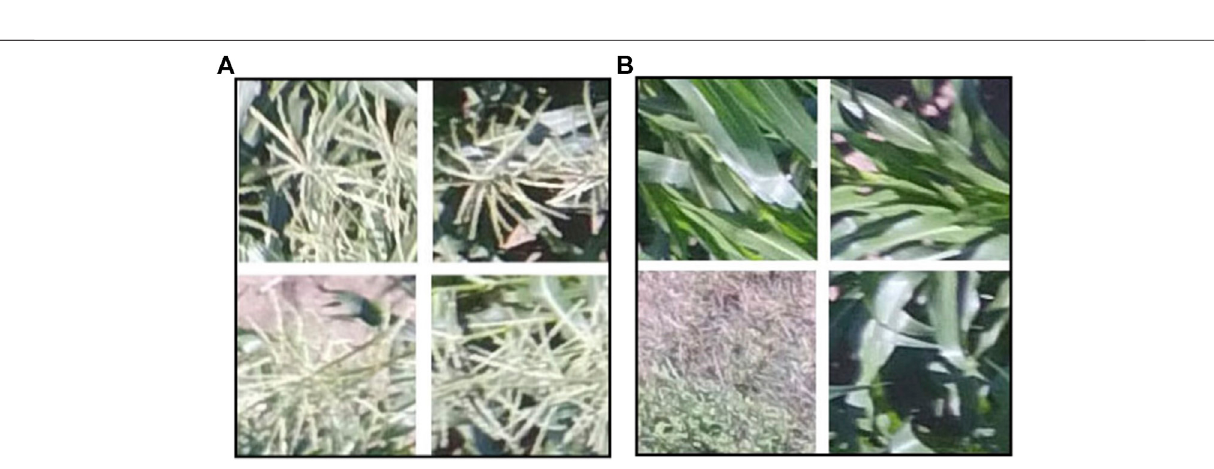
Frontiers in Robotics and AI |